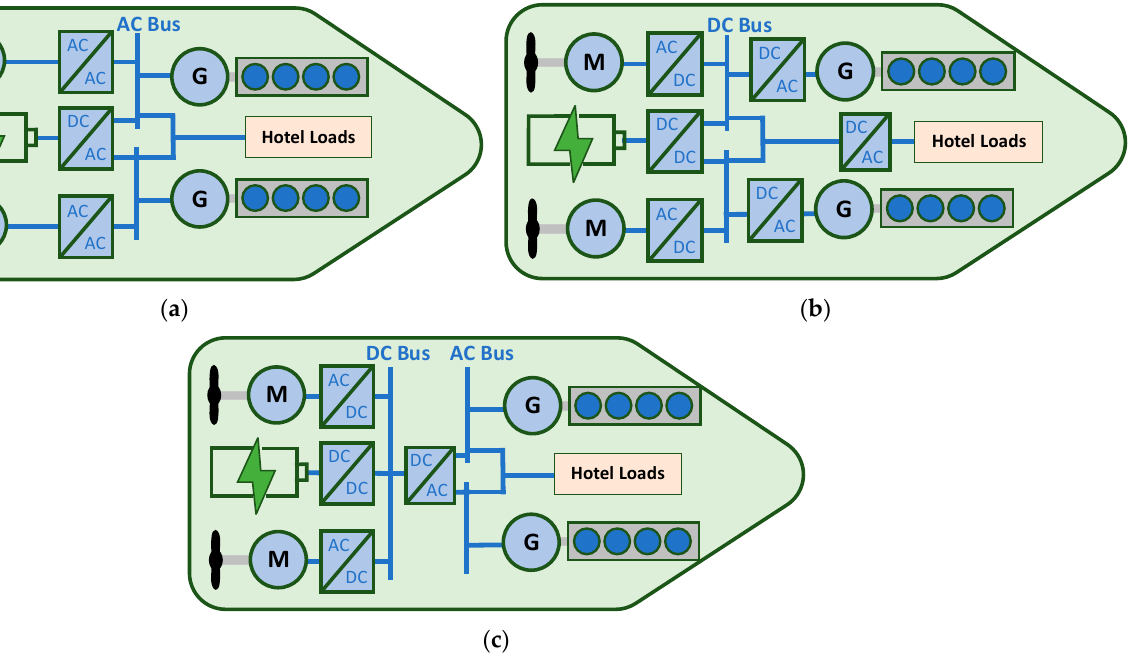
Figure 4. Simplified representation of shipboard microgrid architectures. ( a ) AC shipboard microgrids. ( b ) DC shipboard microgrids. ( c ) Hybrid shipboard microgrids. (Adapted from [35]).